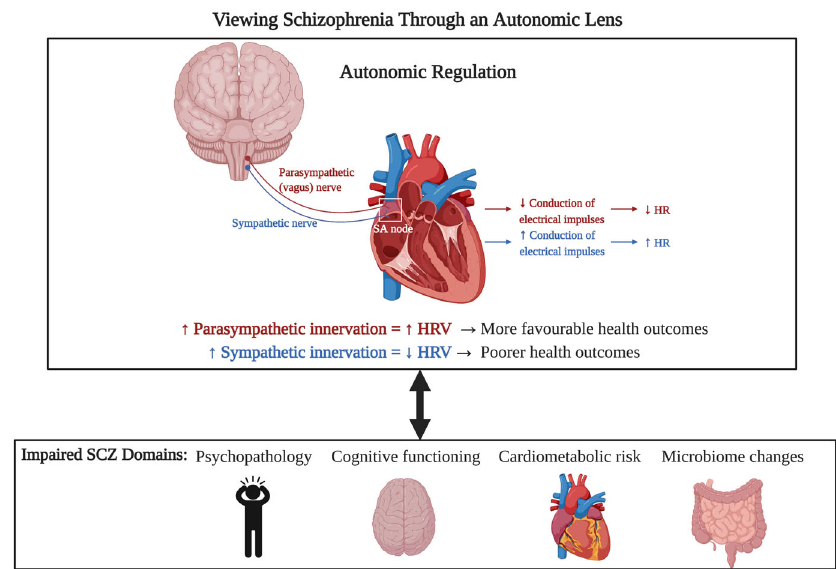
Fig. 4 Implications of autonomic nervous system dysfunction in schizophrenia. Autonomic dysfunction, in the form of increased sympathetic activity and decreased parasympathetic activity, has been implicated in various disease states. Autonomic dysfunction, as assessed through heart rate variability (HRV) and other assessment methods, has been related to various domains of SCZ, including psychopathology, cognitive functioning, cardiometabolic risk, and microbiome changes. The relationship between these domains and autonomic functioning is believed to be bidirectional. SCZ Schizophrenia, HR heart rate, HRV heart rate